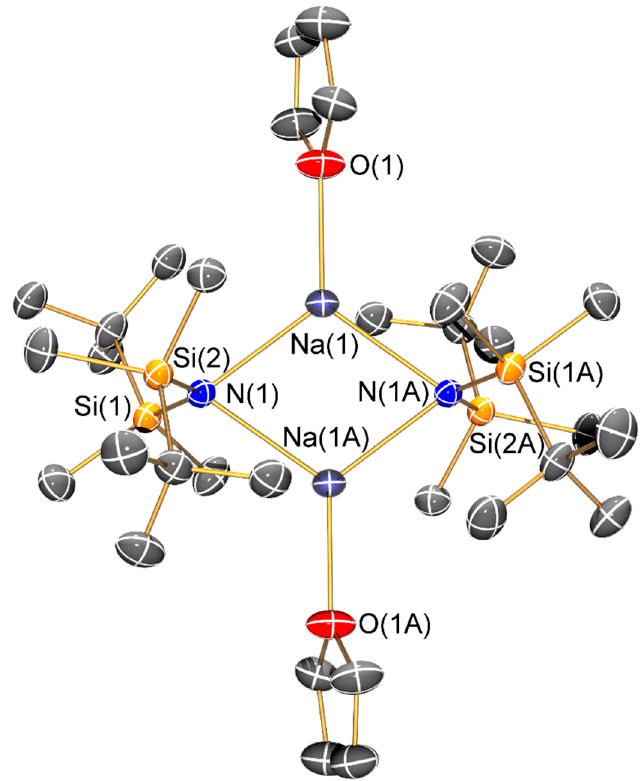
Figure 9. Molecular structure of [Na{ μ -N(Si t BuMe 2 ) 2 }(THF)] 2 ( 9-THF ) with selective atom labelling. Displacement ellipsoids set at 30% probability level and hydrogen atoms omitted for clarity. Symmetry operation to generate equivalent atoms: x , y , z .